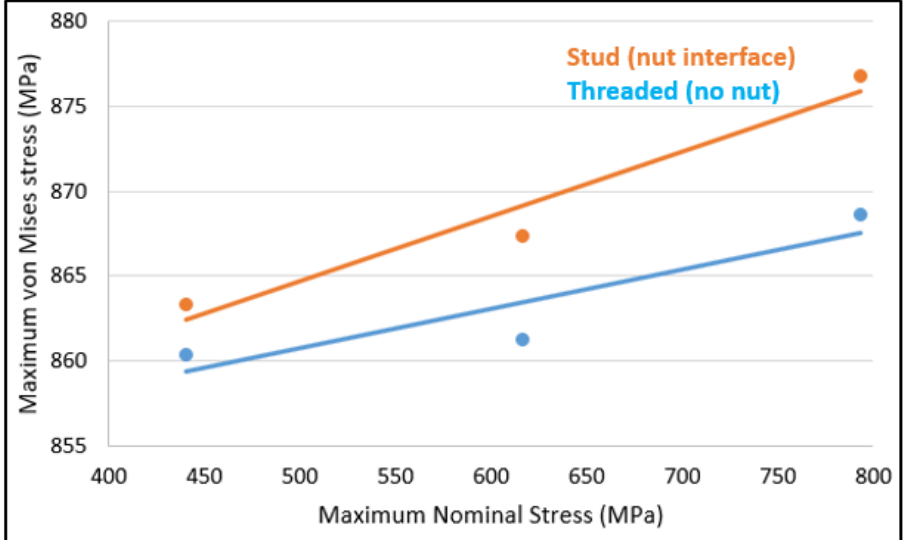
Figure 16. Von Mises stress (MPa) versus maximum nominal stress. Figure 16. von Mises stress (MPa) versus maximum nominal stress. Figure 16. von Mises stress (MPa) versus maximum nominal stress.